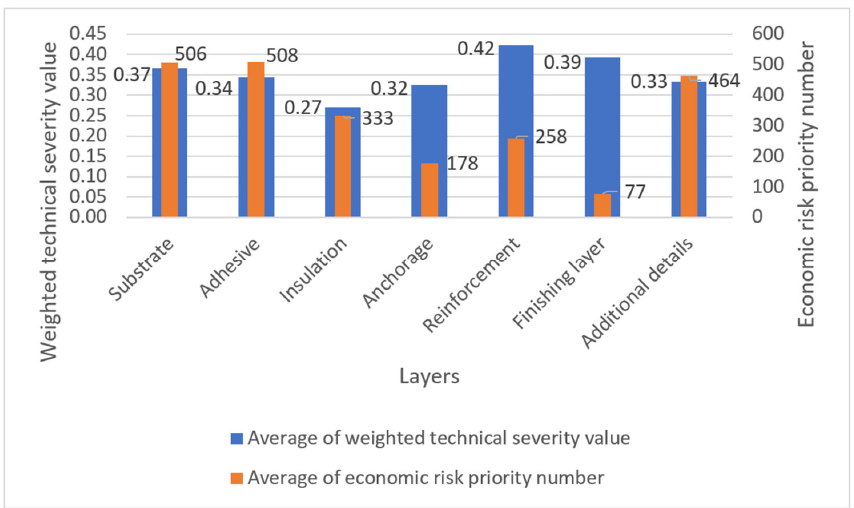
Figure 6. Average of the weighted technical severity value (SV) and economic risk priority number (ERPN) by layers.